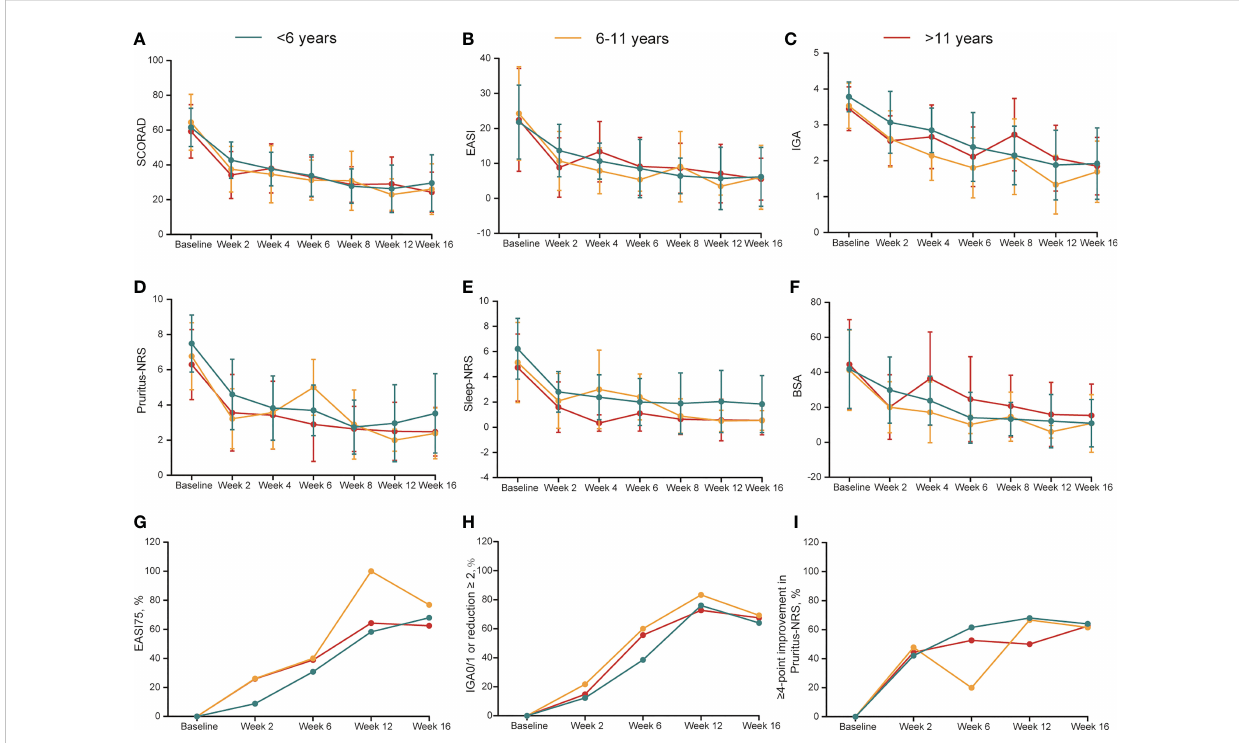
FIGURE 1 (A-F) Dynamic change in SCORAD, EASI, IGA, Pruritus-NRS, Sleep-NRS and BSA during treatment duration across different groups. Data are shown with mean ± SD. (G-I) Dynamic change in the percentage of EASI75, IGA0/1 or reduction ≥ 2 from baseline, ≥ 4-point improvement in Pruritus-NRS during treatment duration. BSA, body surface area; EASI, Eczema Area and Severity Index; EASI75, at least 75% improvement from baseline in EASI; IGA, Investigator ’ s Global Assessment; NRS, Numerical Rating Scale; SCORAD, Scoring Atopic Dermatitis; SD, standard